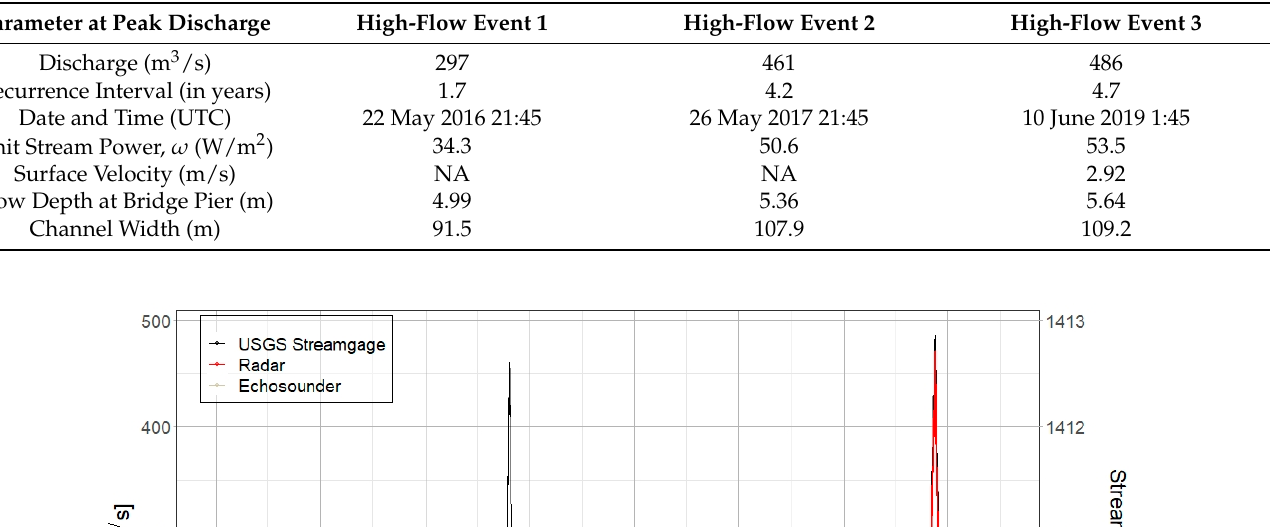
Table 2. Timing and flow characteristics of the peak discharges recorded during high-flow events 1–3.